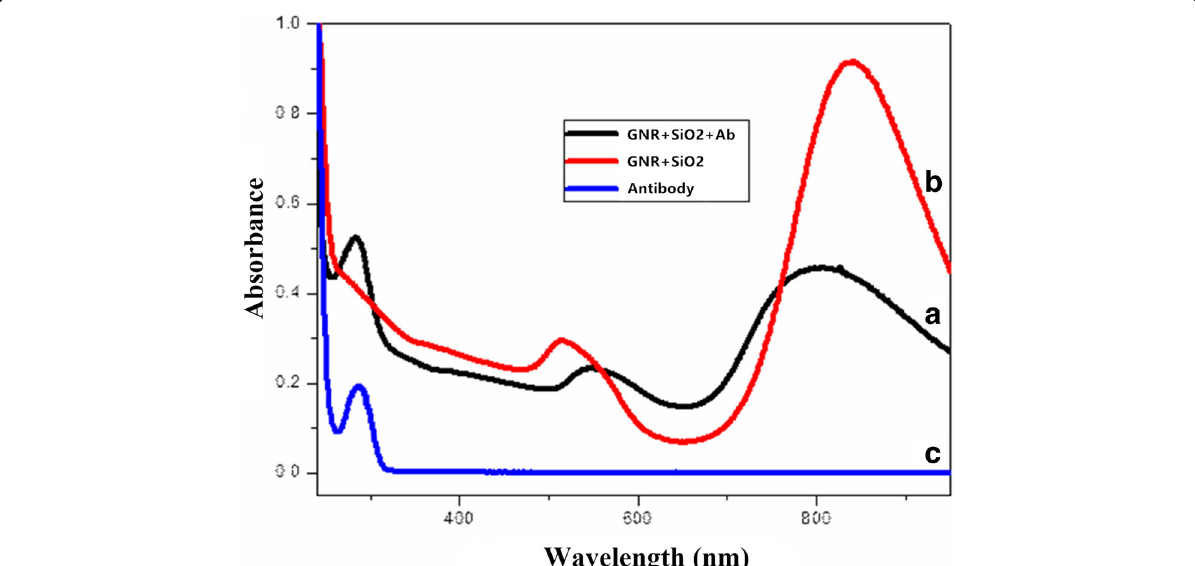
Fig. 3 Absorption spectra of: GNR+SiO 2 +Ab (A), GNR+SiO 2 (B), and anti- C. neoformans antibody (C). The GNR-SiO 2 has two absorption bands, a weak transverse surface plasmon resonance wavelength (TSPRW) around 520 nm and a strong longitudinal surface plasmon resonance wavelength (LSPRW) around 808 nm. After being conjugated with antibodies, the TSPRW and LSPRW of GNR-SiO 2 -Ab are 540 and 835 nm, respectively